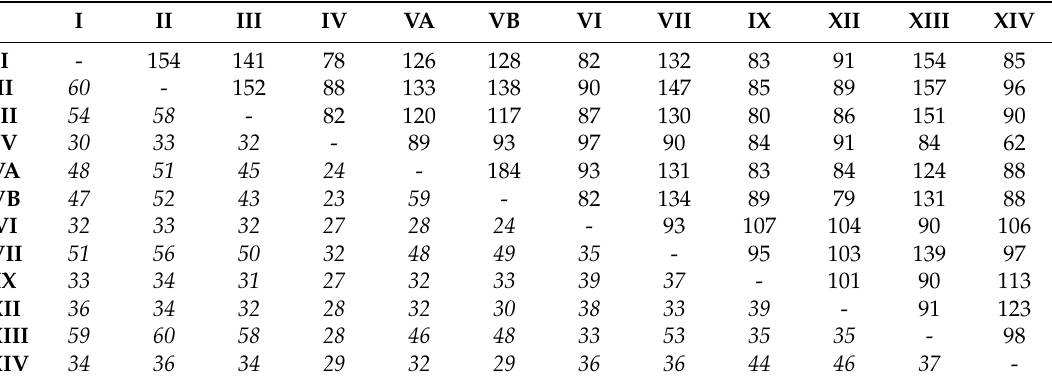
Table 1. Primary sequence identity (%) (italicized, bottom left) and number of conserved residues (right, top) between the catalytically active CA isoforms.